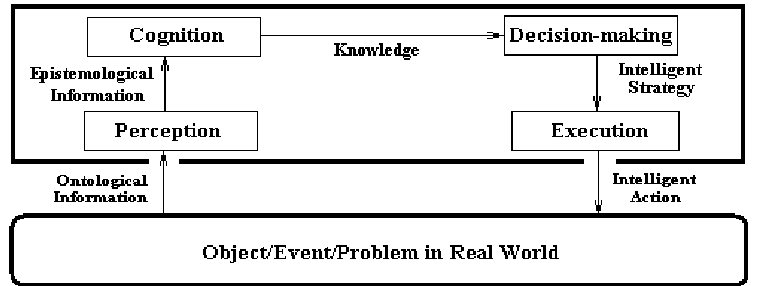
Figure 1. Ecological chain of information within subject–object interactions.